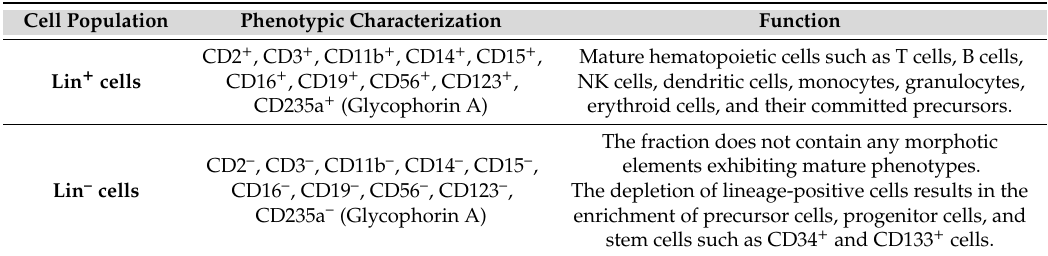
Table 2. The phenotypic characterization of administered autologous Lin −